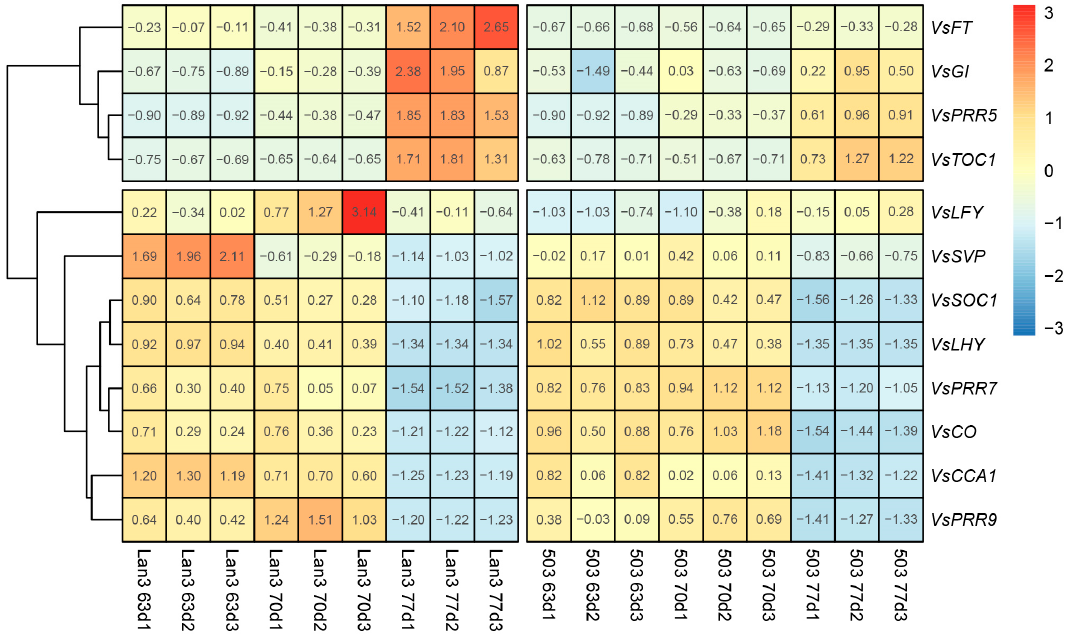
Figure 10. The expression patterns of 12 reported flowering-related genes in Lan3 and 503. The colors indicate the transcript levels calculated as log 2 (FPKM).